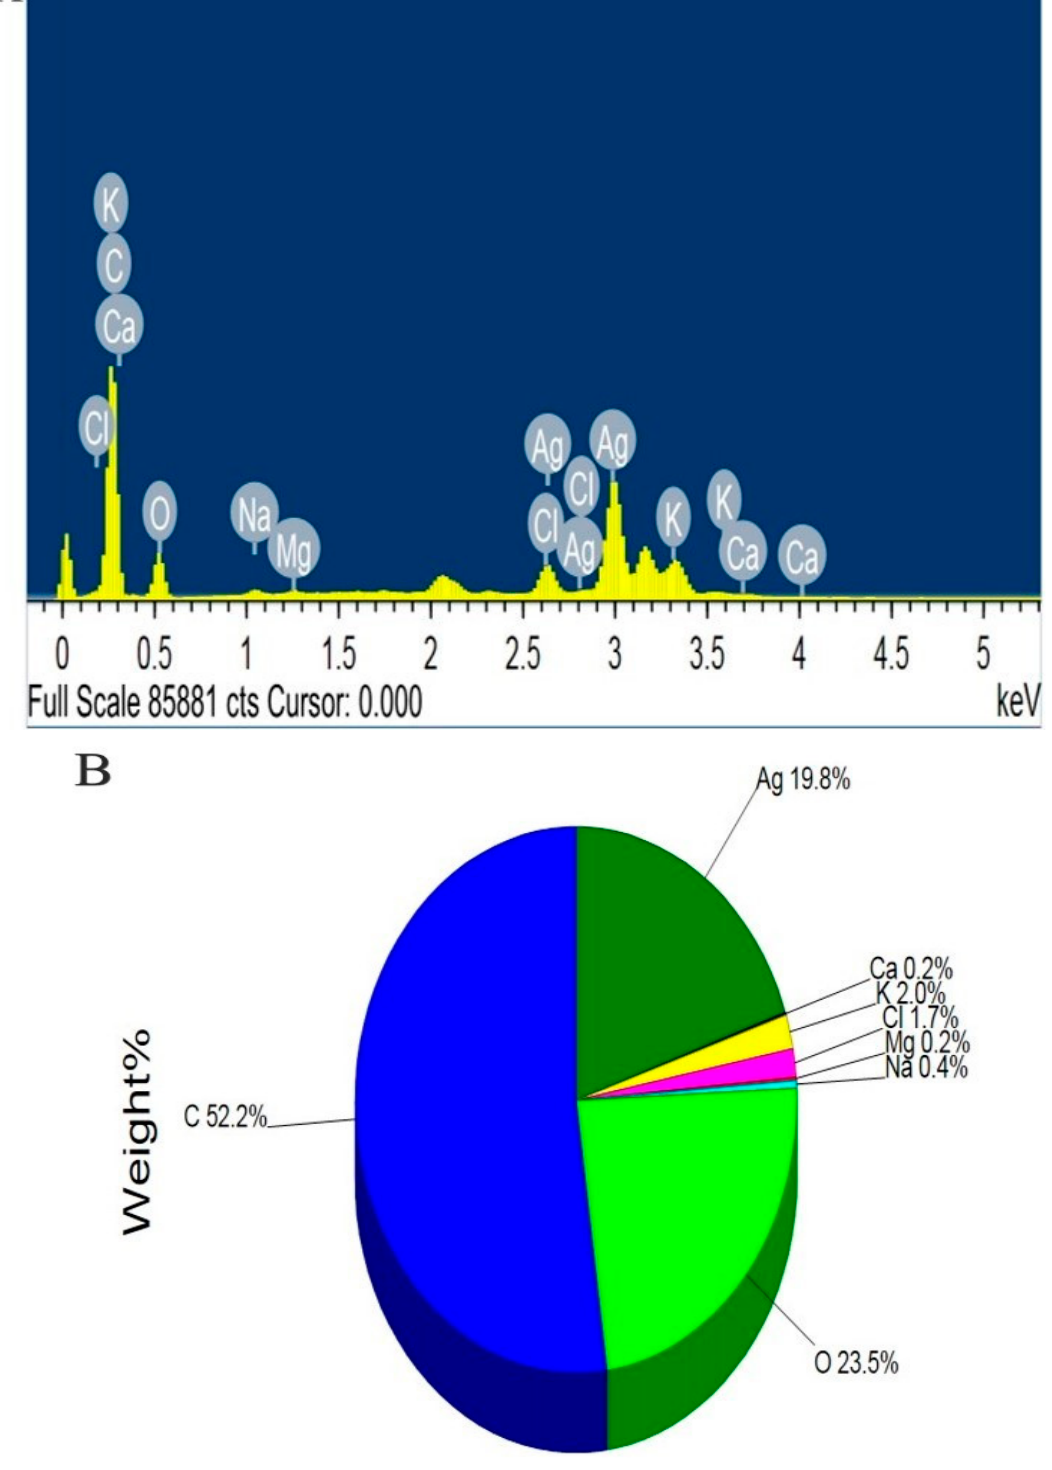
Figure 4. Energy-dispersive X-ray (EDX) spectrum of red currant AgNPs: ( A ) peak related to silver at 3 KeV; ( B ) elemental composition of the red currant AgNPs.